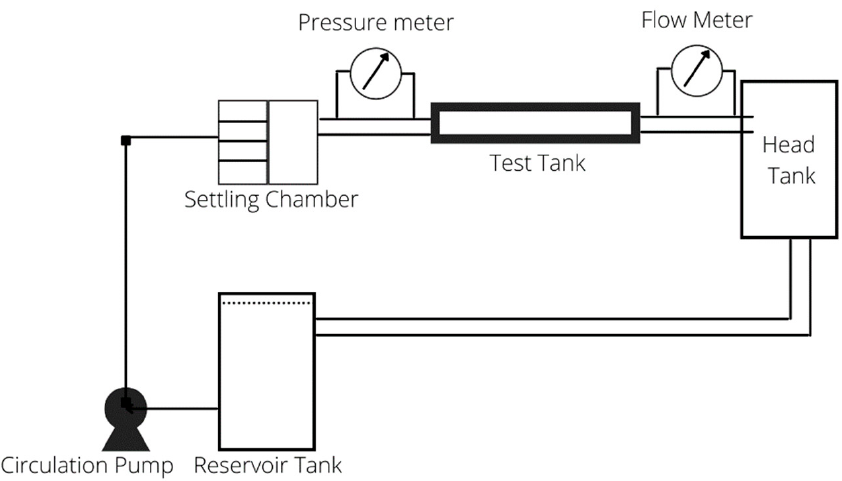
Figure 1. Schematic of the experiment on drag reduction using additives.